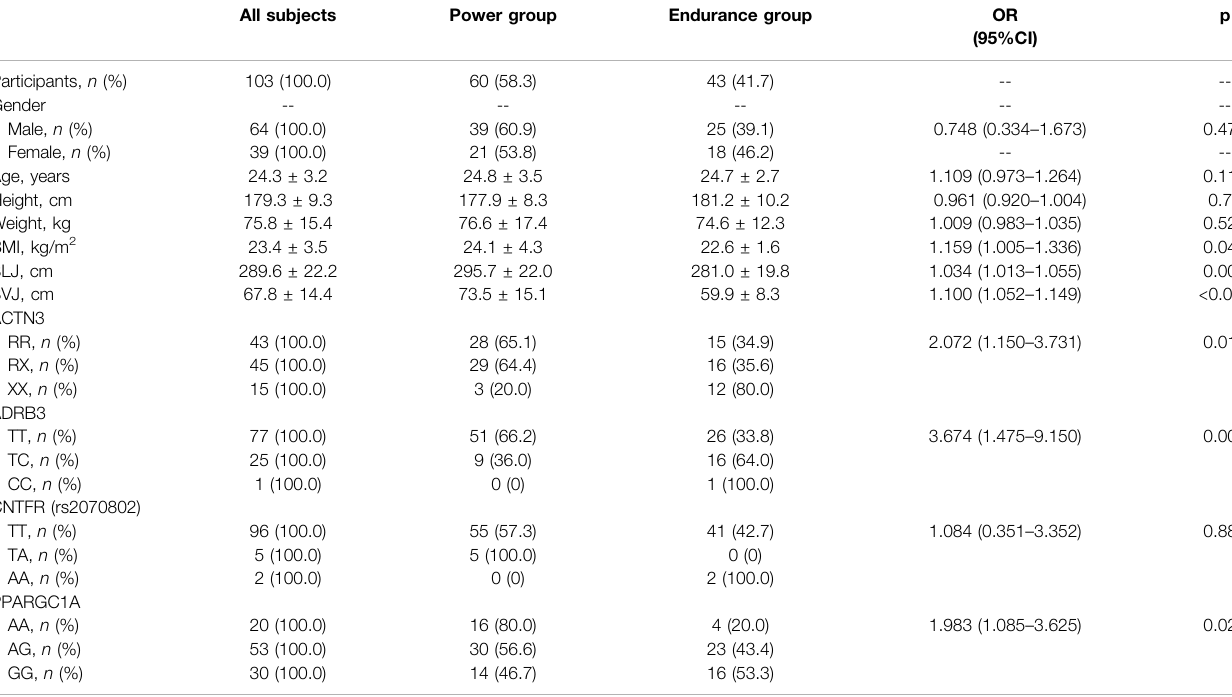
TABLE 2 | Univariate logistic regression analysis for power performance.